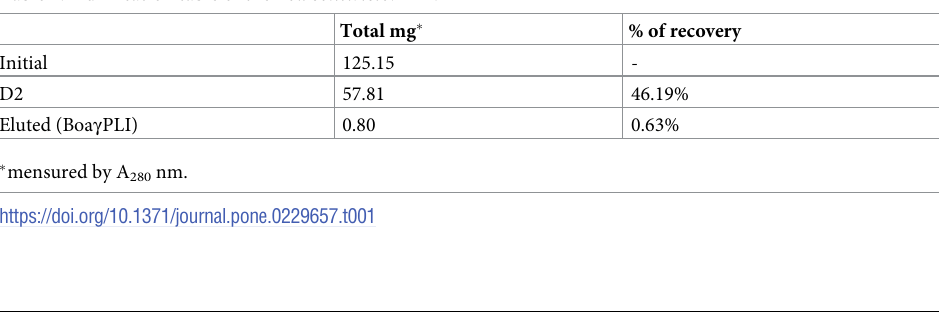
Table 1. Purification table of the Boa constrictor PLI.